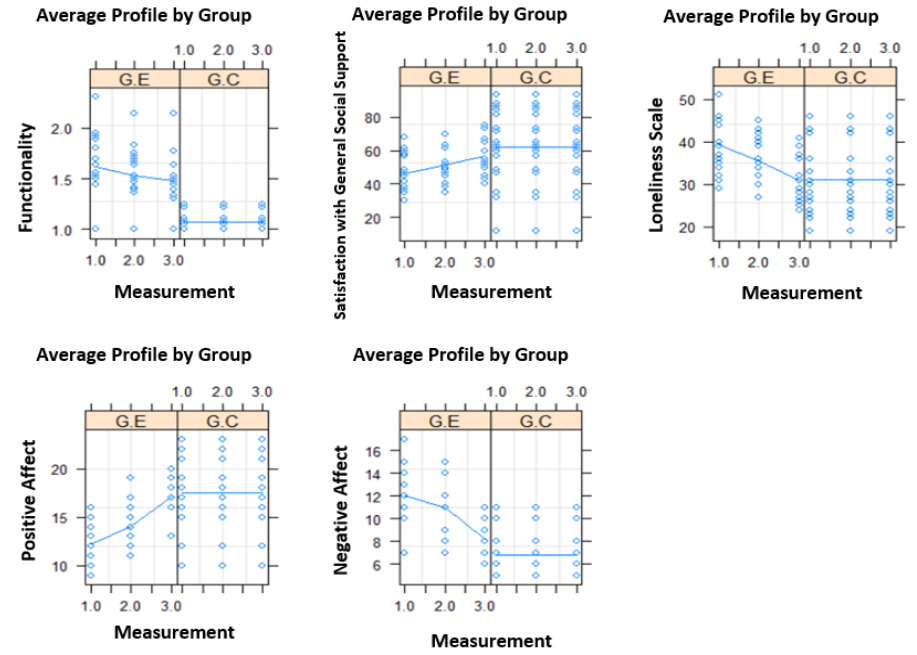
Figure 2. Evolution of each measure by group over the three evaluation moments and average profile of users (solid line) by group.